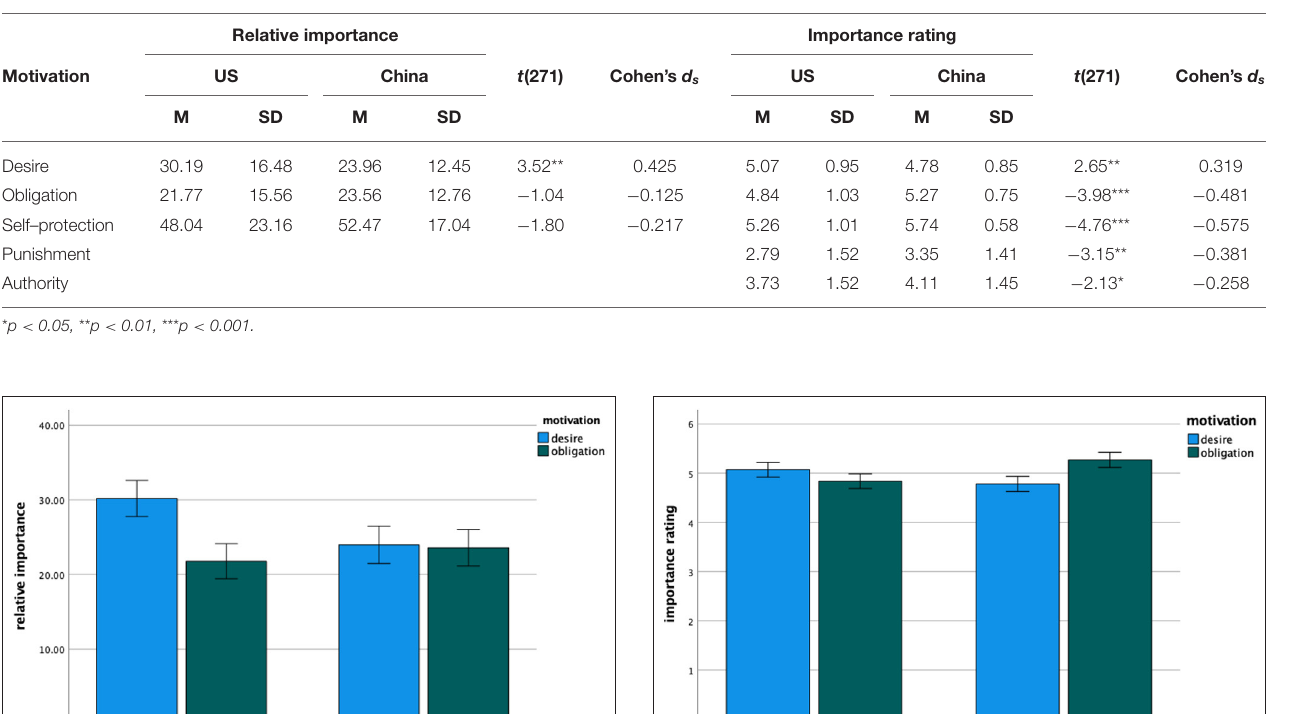
TABLE 9 | Descriptive data for Chinese and American participants’ own motivations.